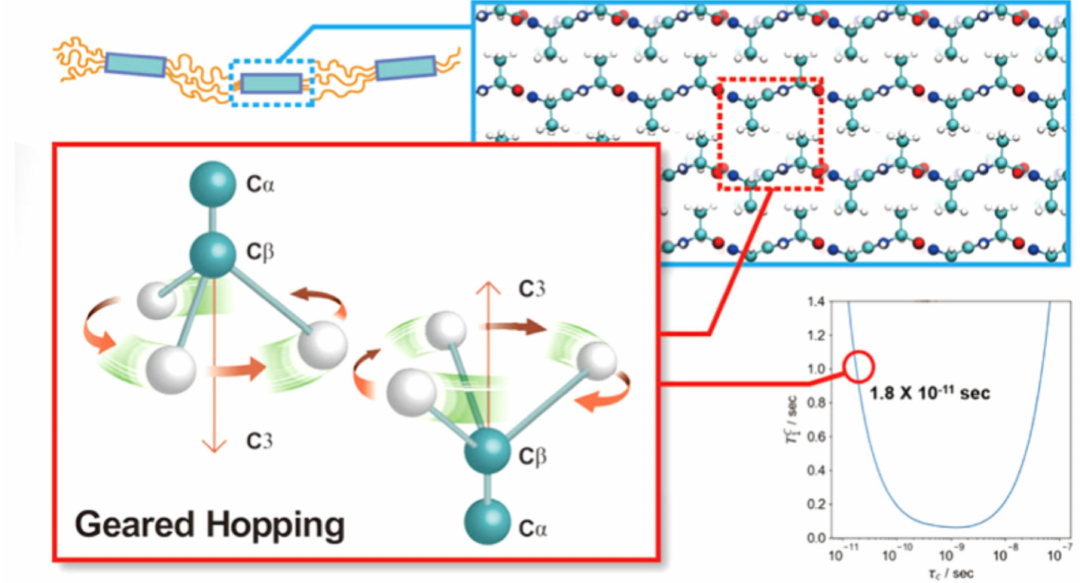
Figure 16. The packing structure and the dynamical behavior of these Ala C β groups in the poly-A region of S. c. ricini silk fibers studied by the MD simulation [110]. Two of the Ala C β carbons out of eight existing in the unit cell of the staggered packing structure exhibited the fastest hopping motion in spite of the shortest C β − C β distance, indicating a geared hopping motion